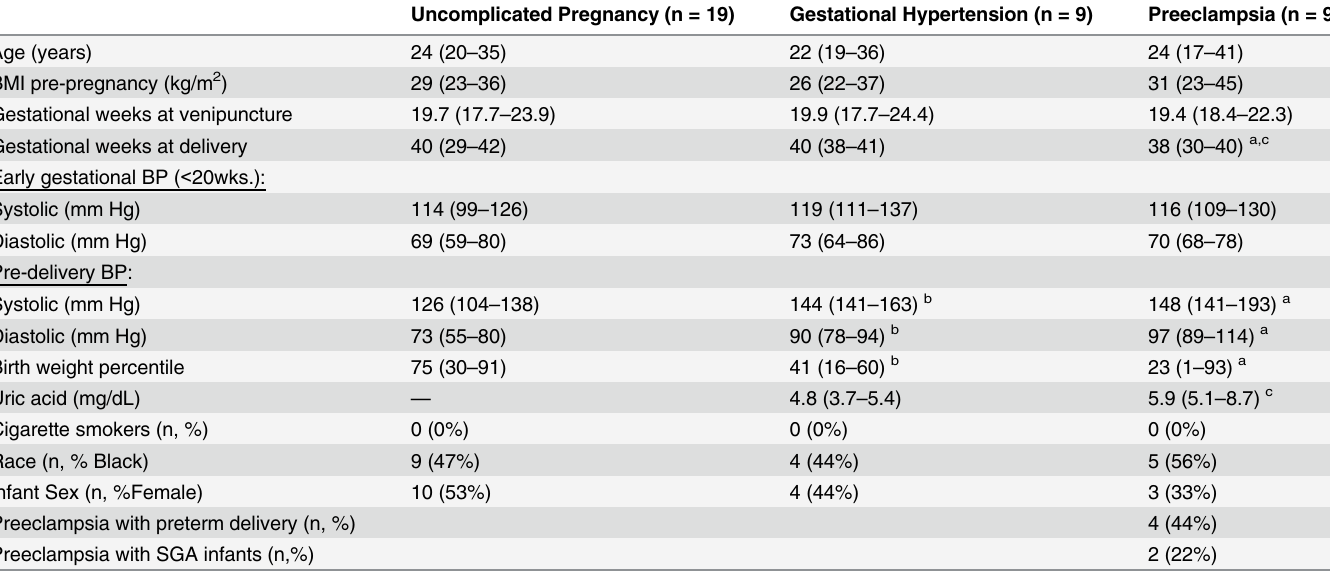
Table 1. Clinical characteristics of uncomplicated pregnancy control (n = 19), gestational hypertensive (n = 9), and preeclampsia (n = 9) groups; for comparison of soluble Sdc1 in gestational age-matched, 2 nd trimester maternal